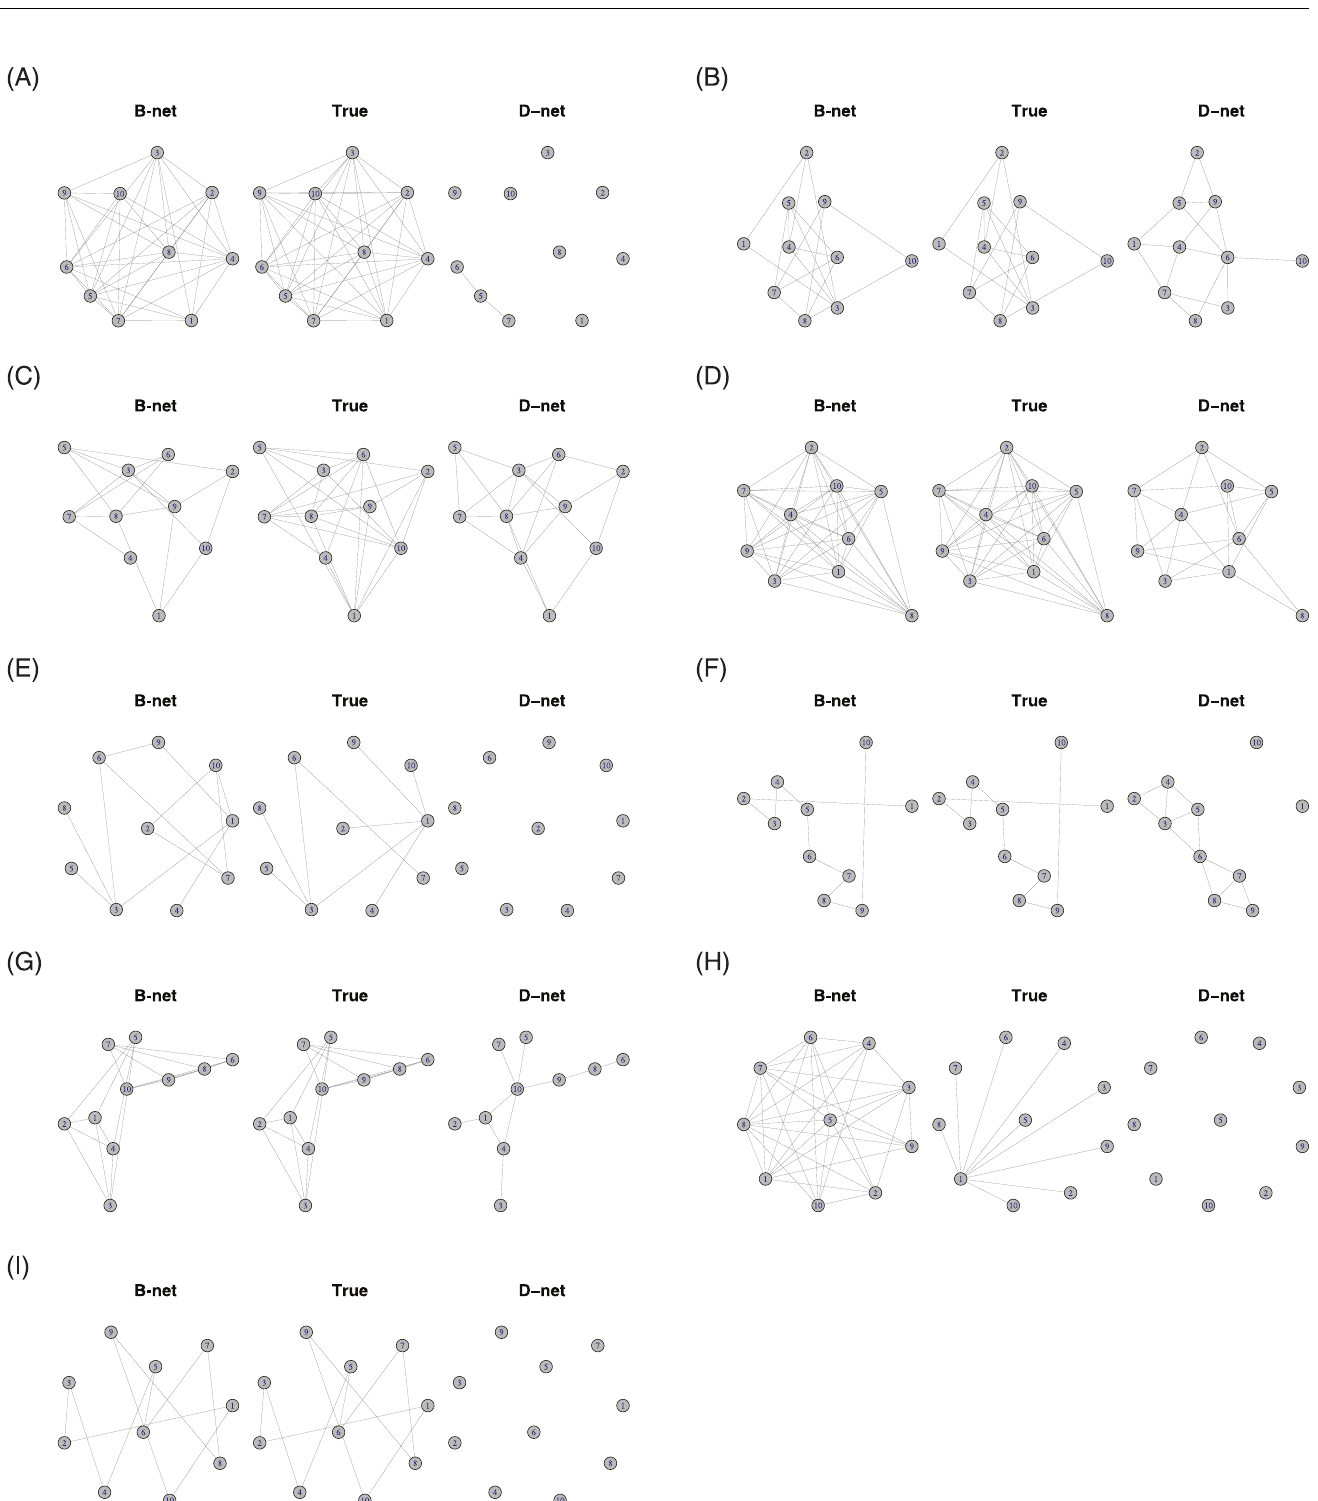
PLOS ONE | https://doi.org/10.1371/journal.pone.0261193 January 25,